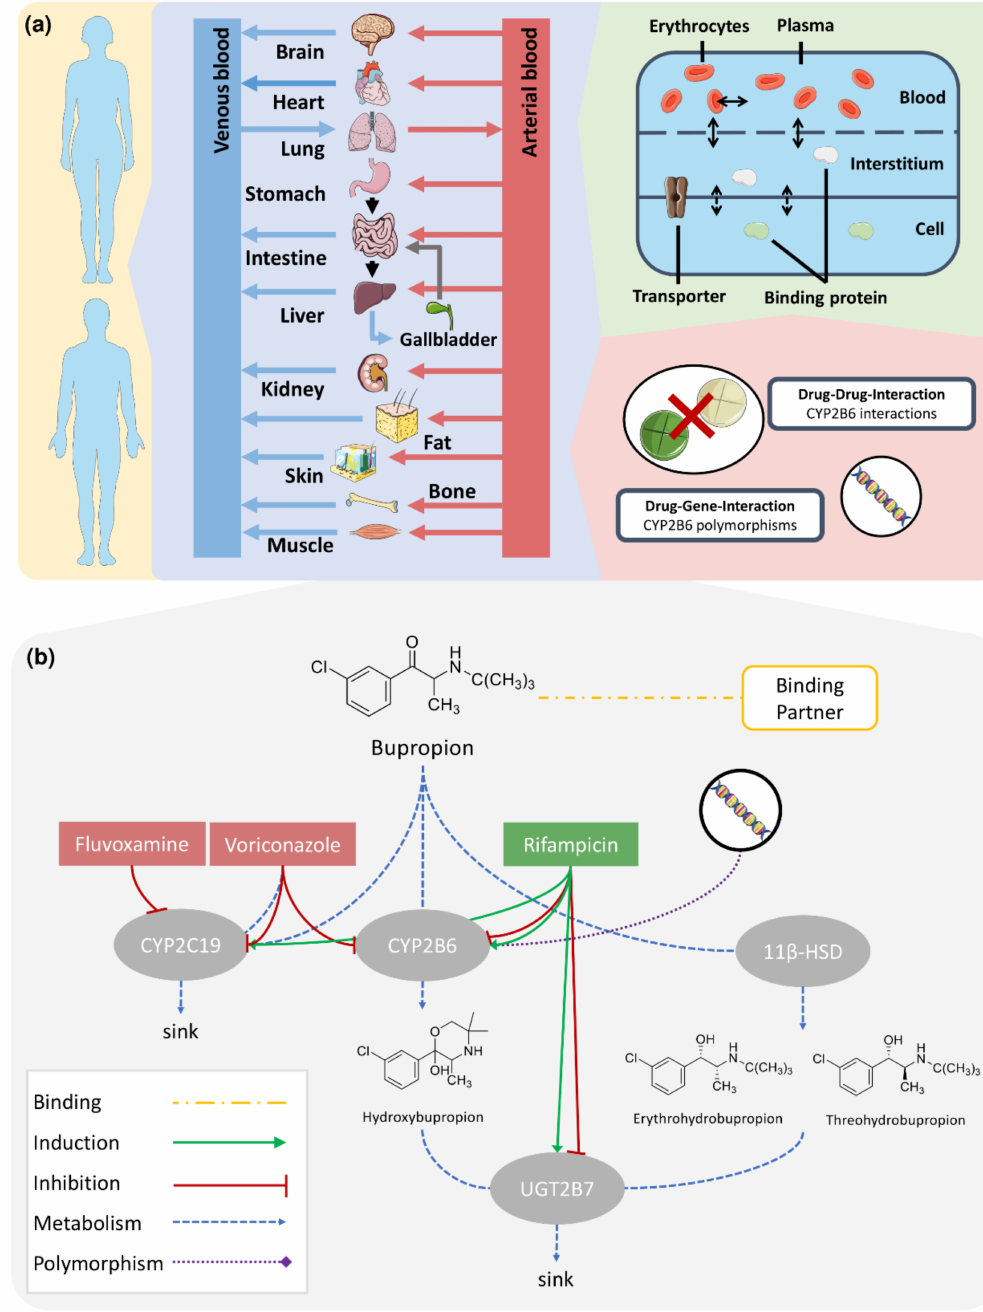
Figure 1. Modeling overview of the CYP2B6 DDGI Network. A whole-body PBPK model was augmented for the simulation of CYP2B6 drug–drug, drug–gene, and drug–drug–gene interactions ( a ). The model describes bupropion’s metabolism via CYP2B6, CYP2C19, and 11 β -HSD ( b ). Its metabolites hydroxybupropion, erythro- and threohydrobupropion are transformed via UGT2B7. Binding to an unspecific binding protein, representing bupropion’s pharmacological targets, was implemented. Several effects on the bupropion PK were modeled, i.e., effects of genetic polymorphisms on CYP2B6; induction of CYP2C19 by rifampicin; induction and inhibition of CYP2B6 and UGT2B7 by rifampicin; inhibition of CYP2C19 by fluvoxamine; and inhibition of CYP2B6 and CYP2C19 by voriconazole. Drawings by Servier, licensed under CC BY 3.0 [68]. 11 β -HSD: 11 β -hydroxysteroid-dehydrogenase, CYP2B6: cytochrome P450 2B6, CYP2C19: cytochrome P450 2C19, UGT2B7: uridine 5 (cid:48) -diphospho-glucuronosyltransferase